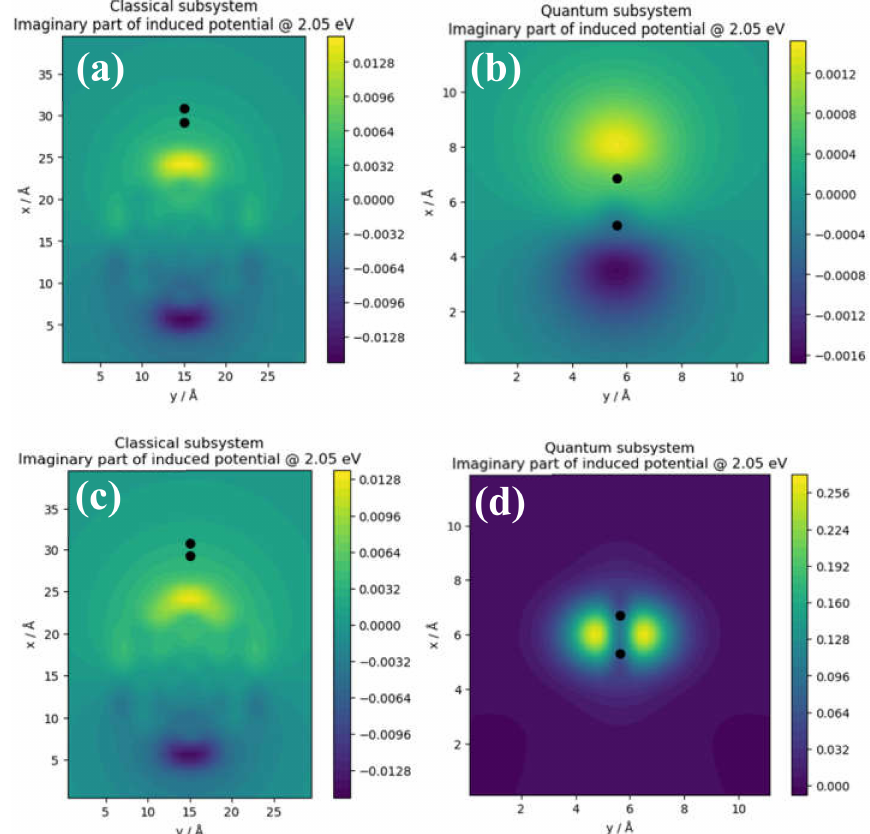
Figure 5. Induced potentials in TaAs (top panels) and graphene (bottom panels) for classical ( a , c ) and quantum ( b , d ), subsystems. The color bars denote the induced potential in